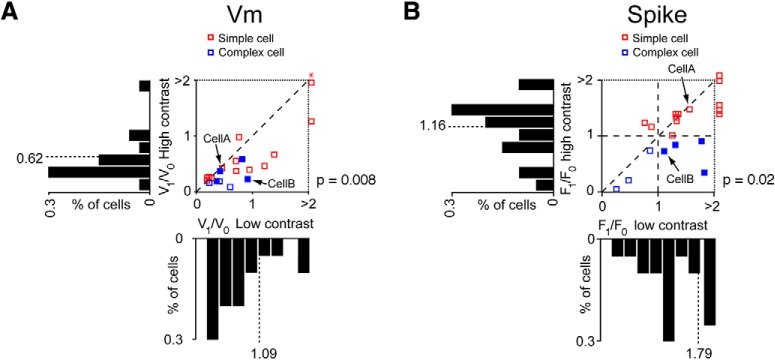
Population results of mouse V1 cells recorded with drifting gratings (n = 20). A: Scatter plots of membrane potential modulation ratios (V1/V0) and B: spiking modulation ratios (F1/F0) at low (16%) and high (64%) contrasts. The diagonal broken lines indicate the unity lines, where the modulation ratios are the same at high and low contrasts. Compared to high contrasts, the modulation ratios showed significant increases at low contrasts in both membrane potential (one-sided t-test, p = 0.008) and spiking rate (one-sided t-test, p = 0.02). Red symbols represent cells that have F1/F0 > 1 (simple cells) at high contrast. Blue symbols represent cells that have F1/F0 < 1 (complex cells) at high contrast. In B, the horizontal and vertical broken lines indicate F1/F0 = 1. Data from the example cells in Figure 4 are marked as Cell A and Cell B on both A and B. Histograms of distributions of modulation ratios at high and low contrasts are plotted on the same scale next to the corresponding scatter plot axis. The broken lines indicate the means of the distributions. (A: * V1/V0 at low contrast: 4.55, V1/V0 at high contrast: 7.22).